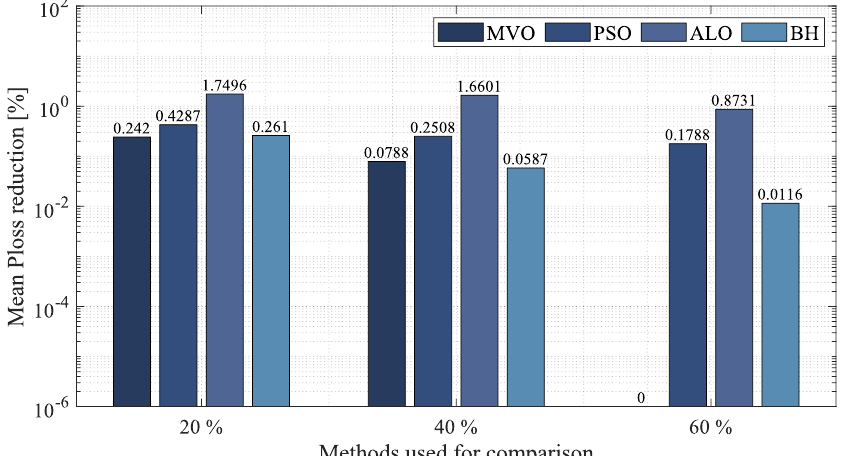
Figure 13. Percentage of reduction of average power losses obtained by the MVO in the 69-node radial system compared to other methodologies.